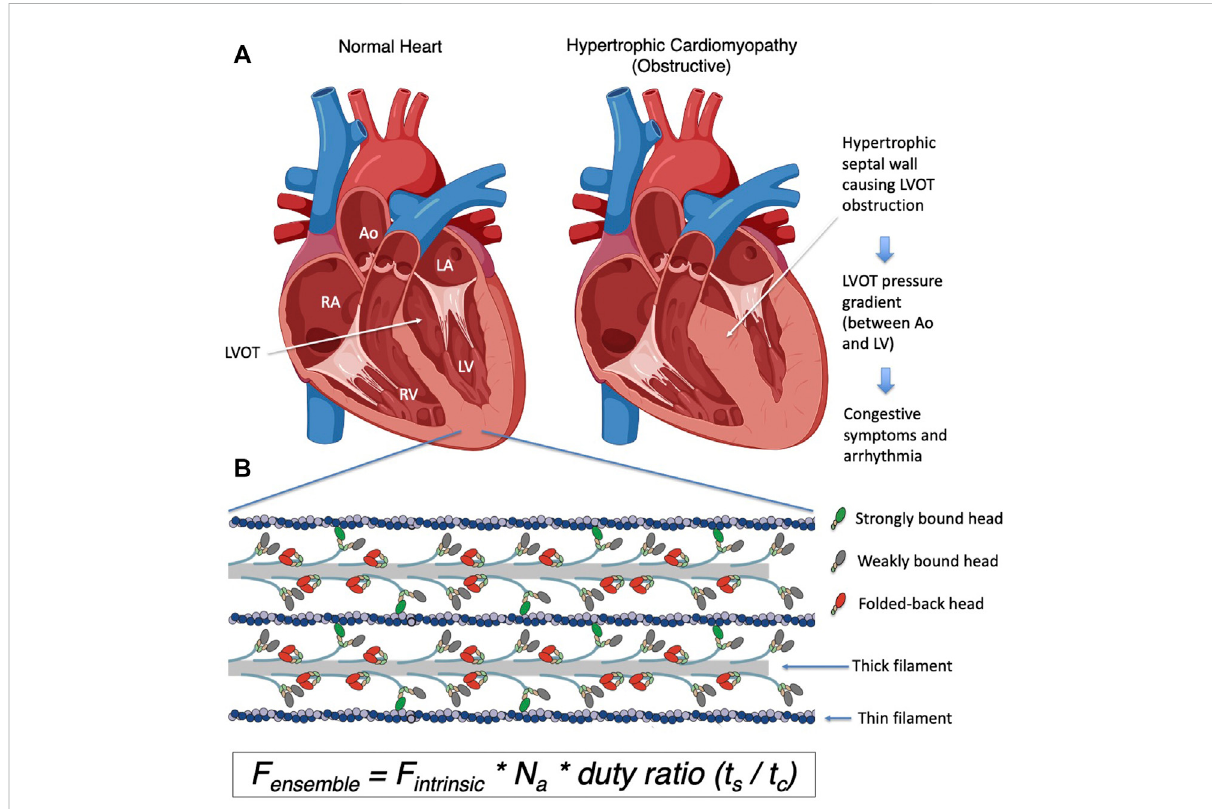
FIGURE 1 (A) Schematic representation of a normal heart and a heart with obstructive hypertrophic cardiomyopathy. The obstruction to blood fl ow occurswhentheseptalhypertrophyimpedesblood fl owfromtheleftventricularcavitytotheaorta via theleftventricularout fl owtractorLVOT, and apressuregradient fromtheleftventricleto theaortaoccurs. (B) Acloseupschematicdrawing ofasarcomere,showingthemyosincontainingthick fi lamentsinterdigitatingwiththeactincontainingthin fi laments.Themyosinheadshighlightedinredarefoldedbackontothethick fi lamentand are unavailable to interact with actin. Myosin heads bound to actin are shown in green, and heads that are released from the thick fi lament but not bound to actin are shown in grey. The number of available myosin heads (N a ) is the sum of green and grey heads within each sarcomere. The duty ratio is de fi ned as the proportion of the total cycle time (t c ) an available myosin head spends strongly bound to actin (t s ). This ratio (t s /t c ) determines the proportion of available heads that are strongly bound to actin in the sarcomere during systole. LA, left atrium; LV, left ventricle; RA, right atrium; RV, right ventricle; Ao, aorta; LVOT, left ventricular out fl ow tract. Figure 1A was created using